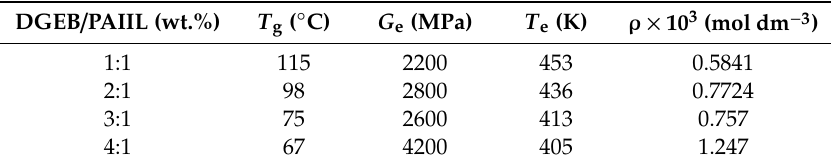
Figure 10. DMTA analysis of the cured DGEB/PAIIL (4:1) system. Table 2. DMA and crosslinking densities data of DGEB /